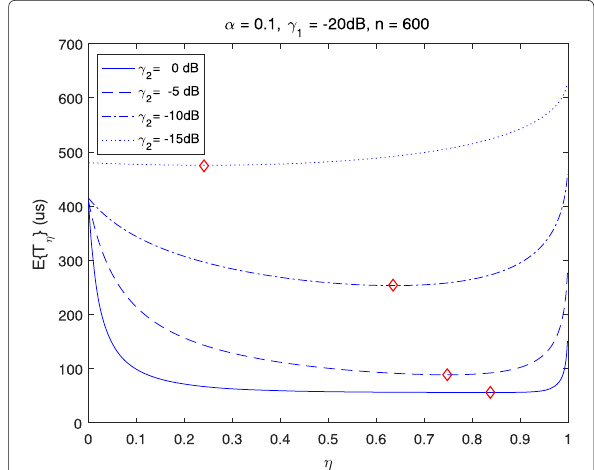
Fig. 5 Average vacating time versus relay policy under different SNRs